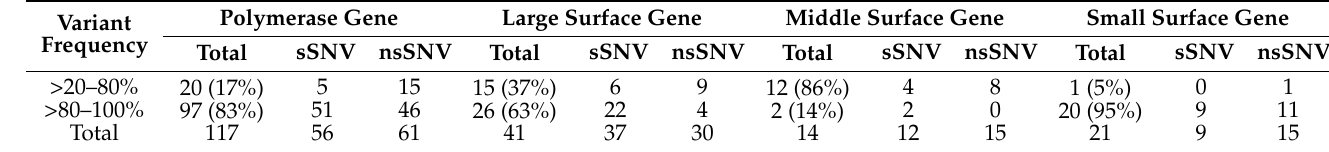
Table 4. sSNV and nsSNV frequencies from the polymerase and surface coding regions of sample HBV 10. Polymerase Gene Large Surface Gene Middle Surface Gene Small Surface Variant Frequency